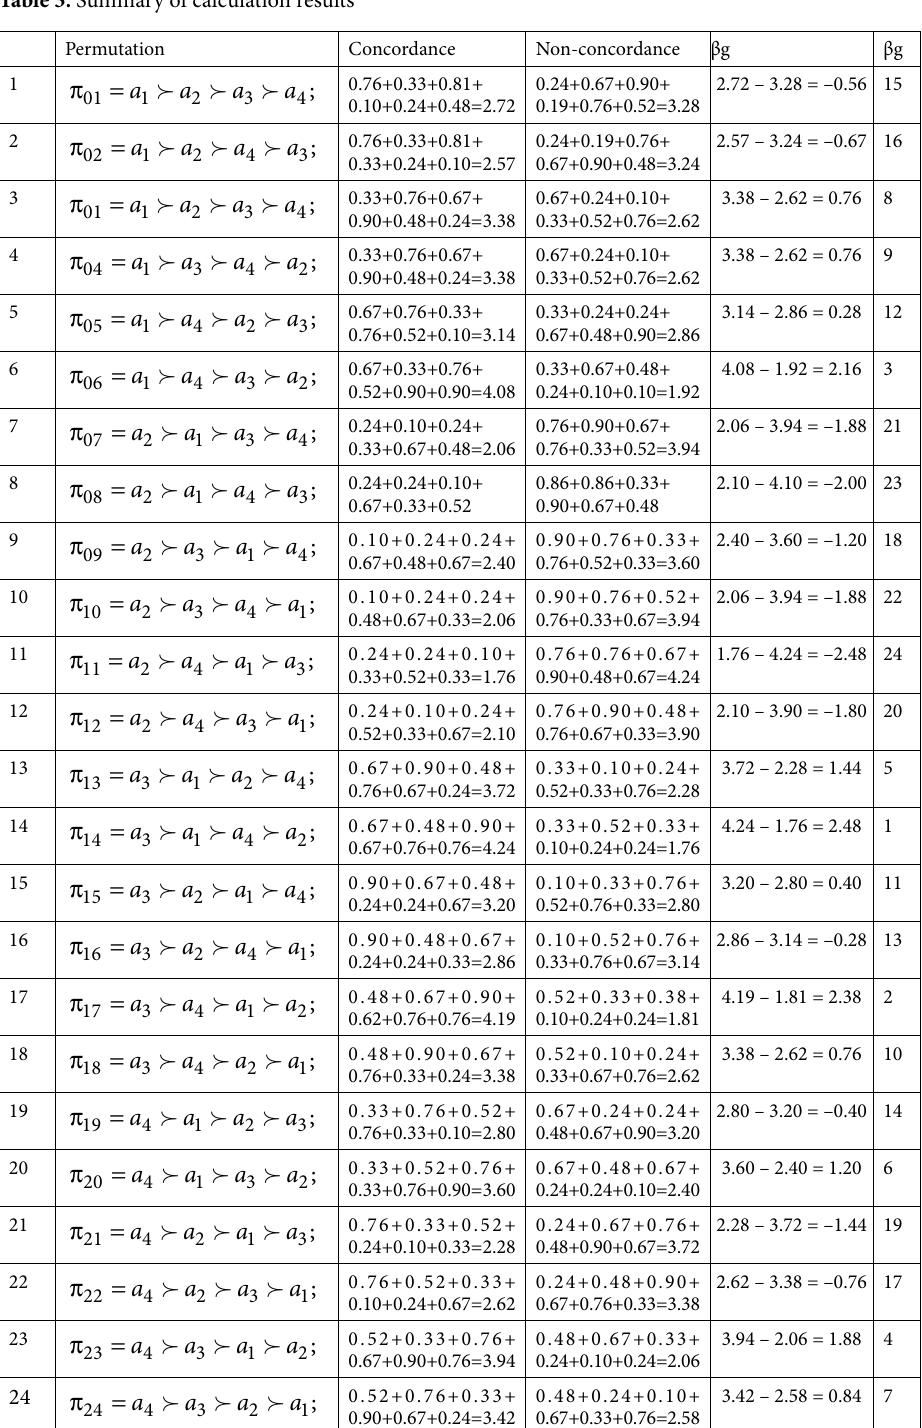
Table 3. Summary of calculation